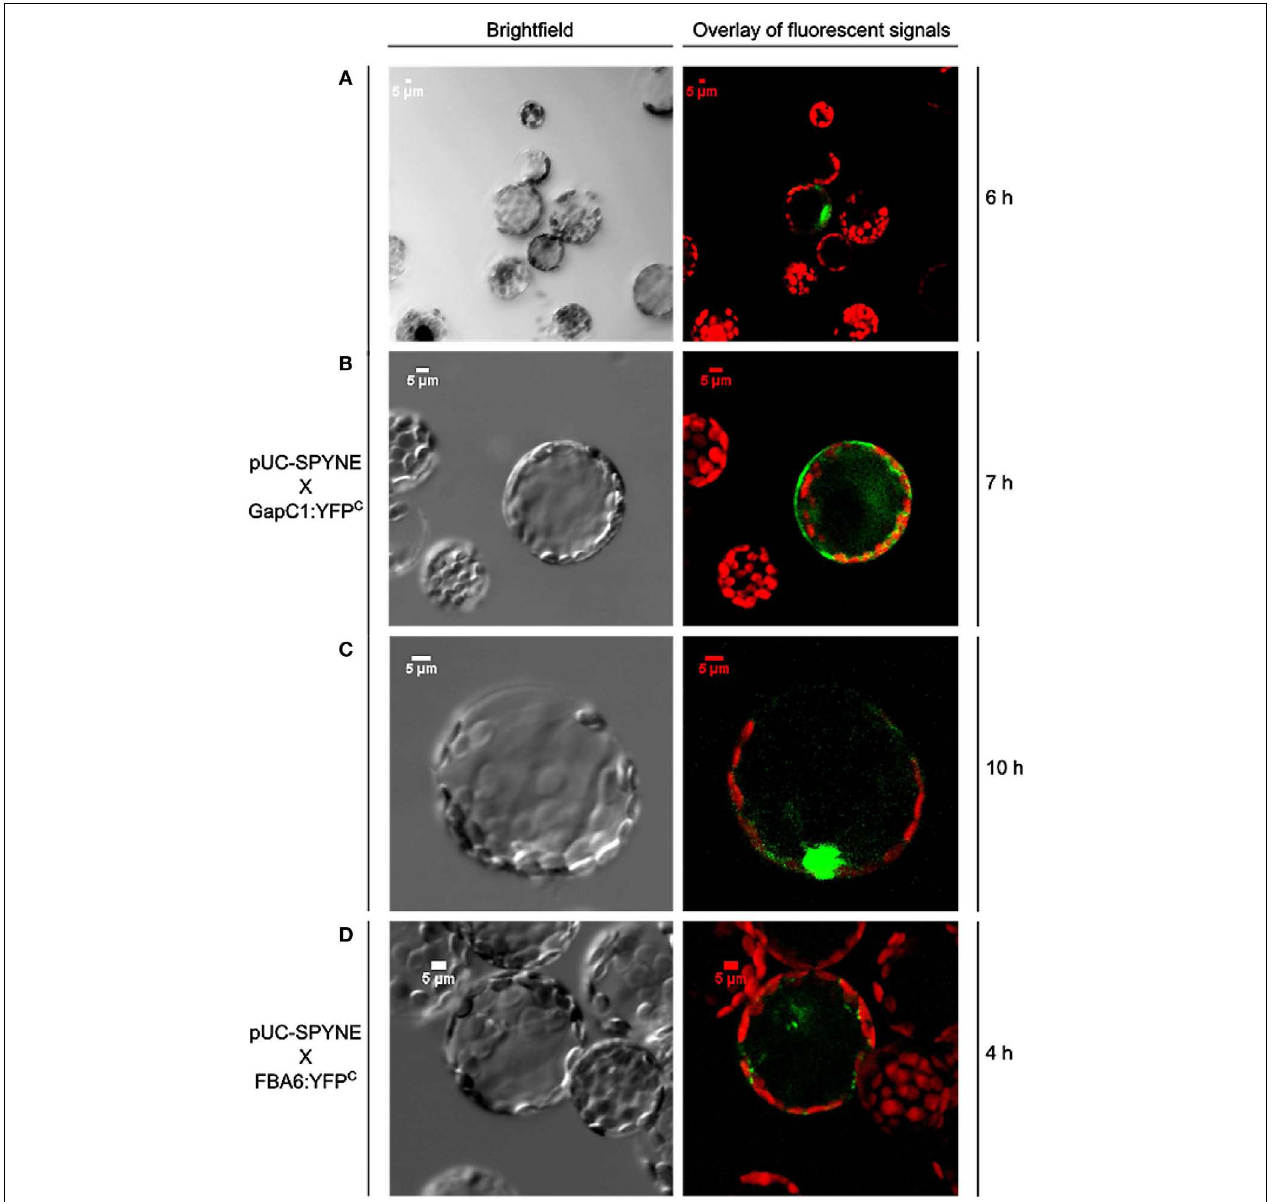
of A. thaliana plants. (A-C) is a time course of the expression of the empty vector with only the N-terminal half ofYFP and GapC1 fused with the C-terminal half ofYFP. In (D) , the same is shown for FBA6 after 4